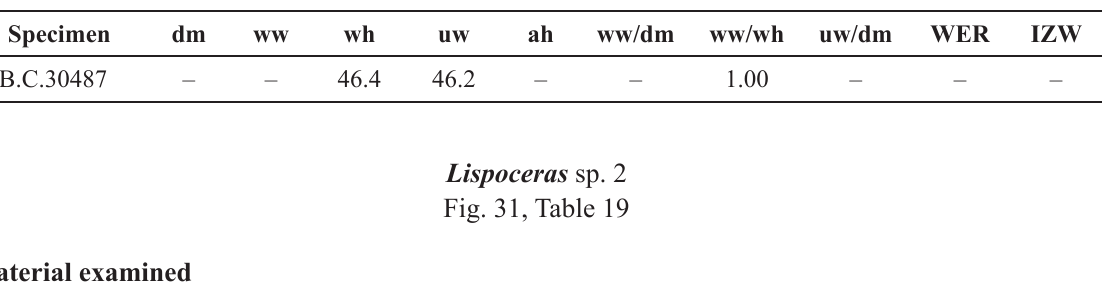
Table 18. Conch dimensions (in mm) and ratios of Lispoceras sp. 1.